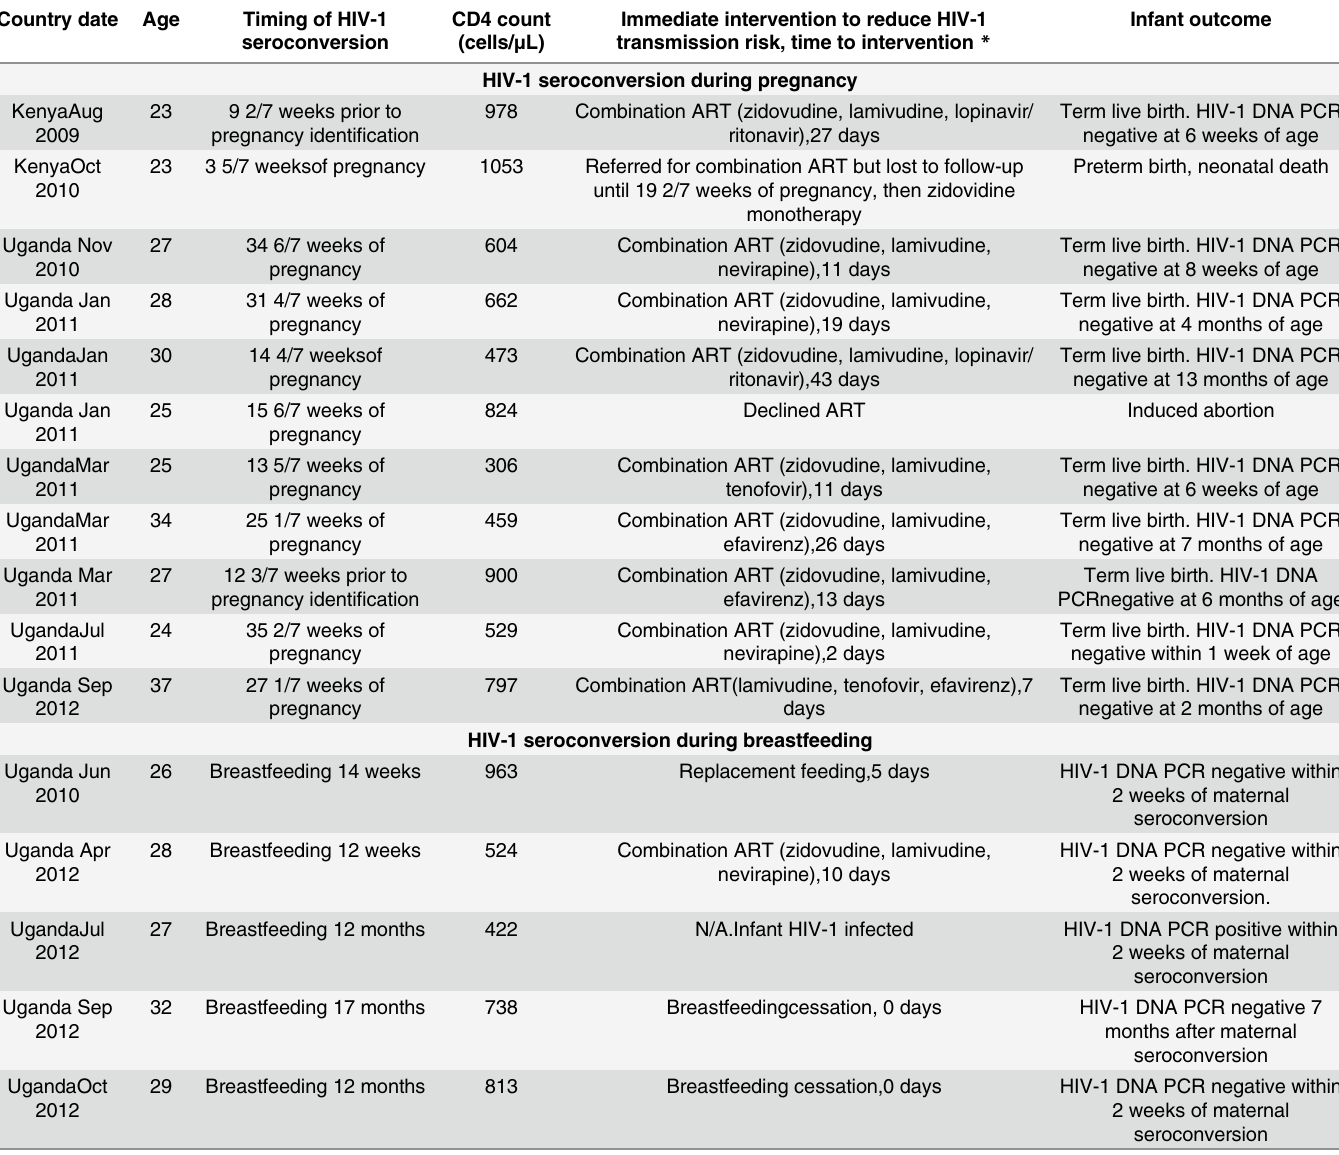
Table 1. Participants with primary HIV-1 infection identified during pregnancy or breastfeeding.